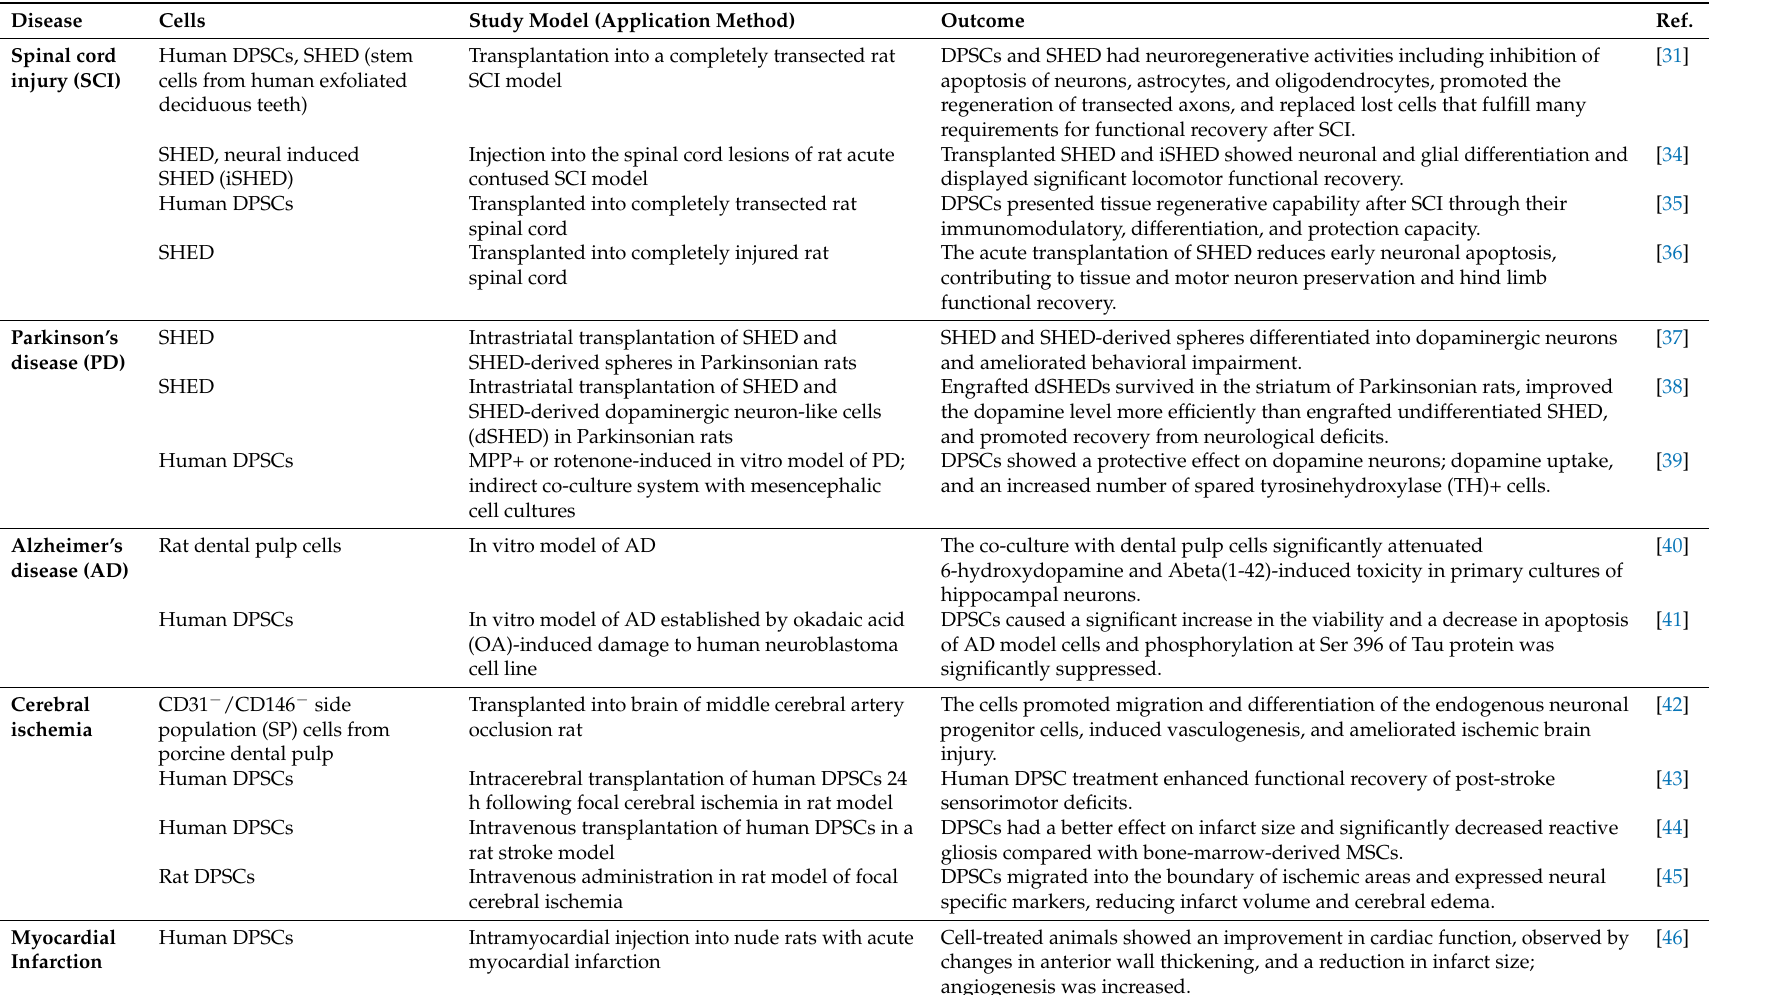
Table 1. Therapeutic potential of Dental pulp stem cells (DPSCs) in various